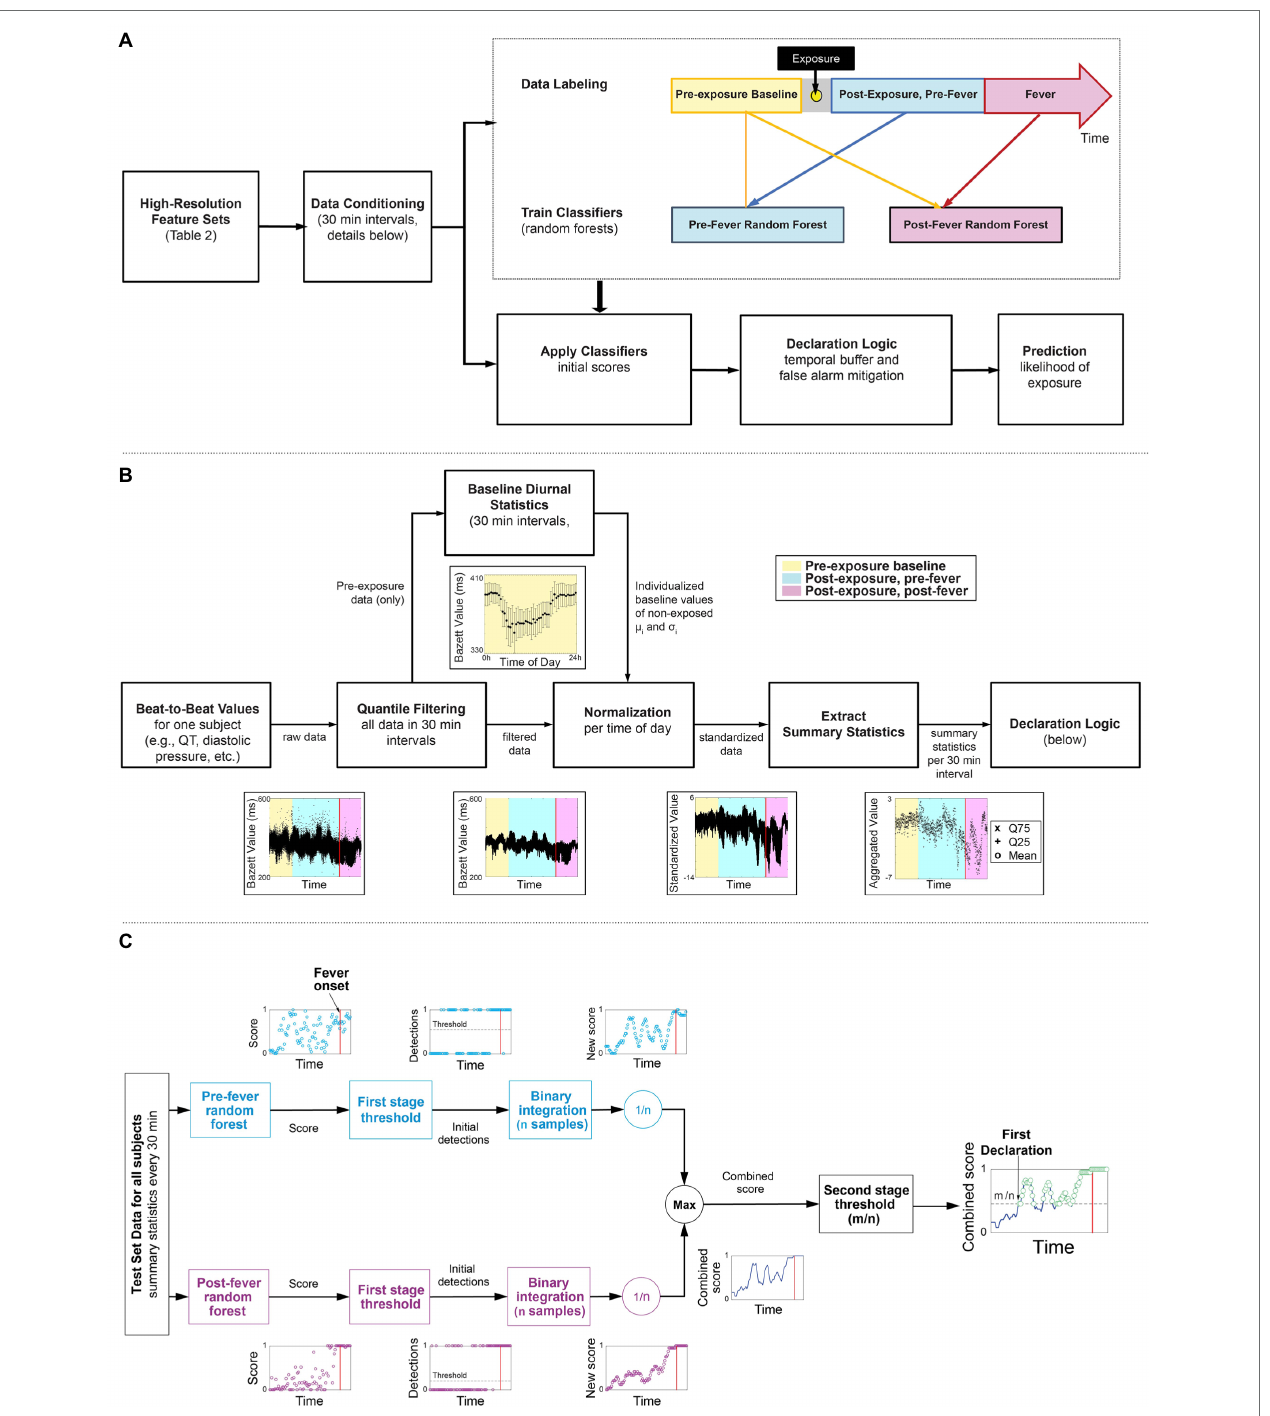
FIGURE 2 | Overview of the workflow of our early warning algorithm. (A) Top level approach including the timeline for labeling the data. (B) Detail on how beat-by- beat data is conditioned to remove noise and diurnal cycles and summary statistics are extracted as features for the two classifiers. (C) A block diagram of a two-stage detection logic to reduce false